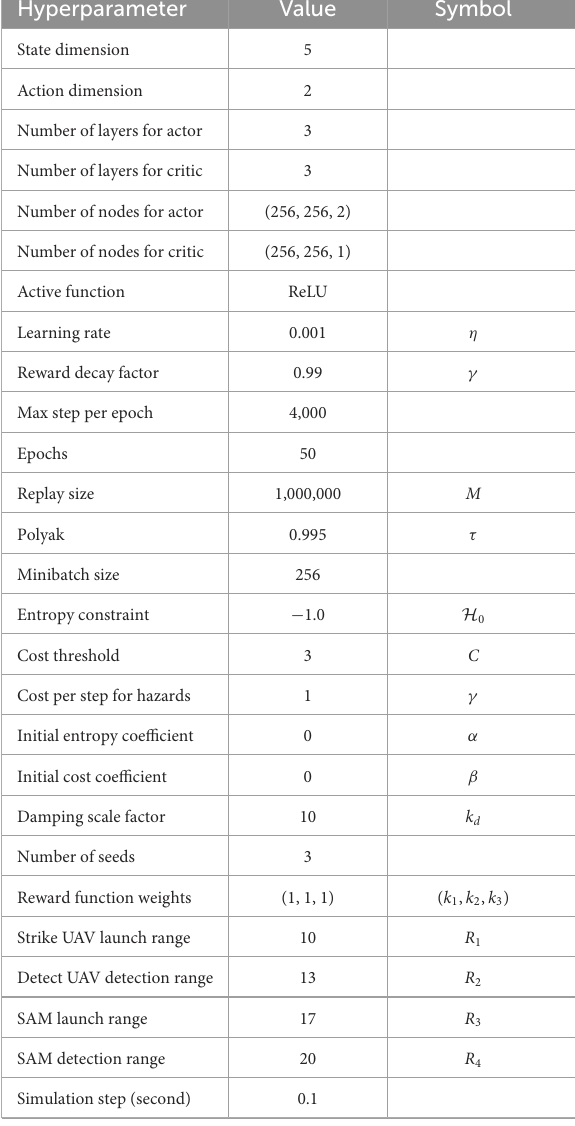
TABLE 3 Simulation